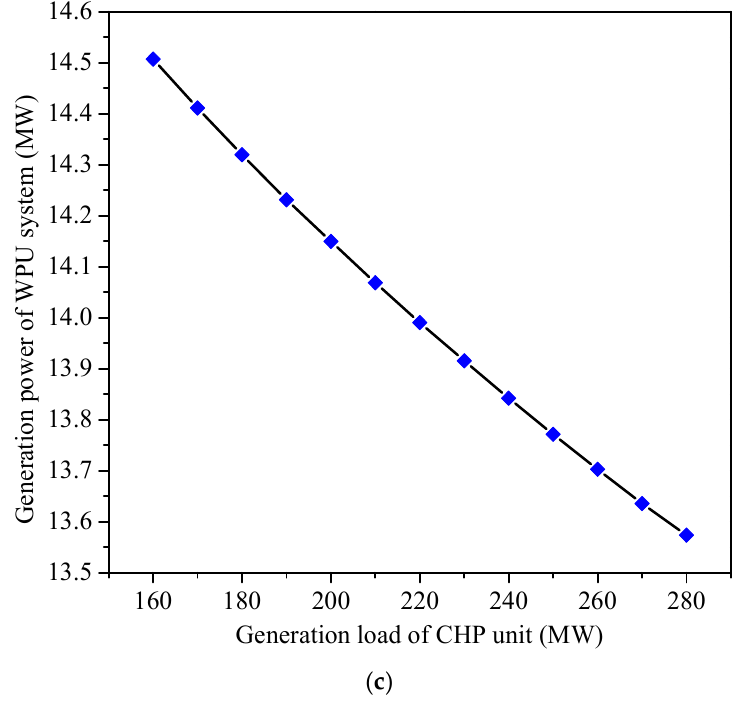
Figure 10. Effect of the unit generation load on the thermal performances of the original and improved CHP units (the unit heating load was set as 200 MW, and the supply and return-water temperatures were set as 95 °C and 50 °C). ( a ) Power generation thermal efficiency; ( b ) power generation standard coal consumption rate; and ( c ) generation of power of the WPU system.